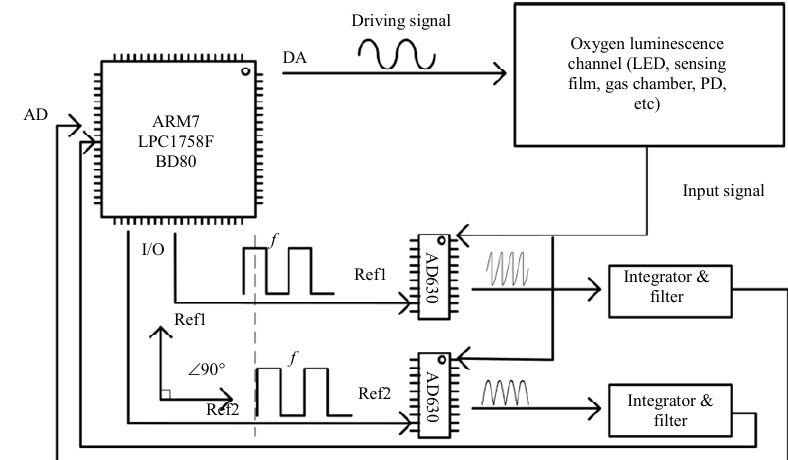
Fig. 5 Sketch of the experimental setup utilized for O 2